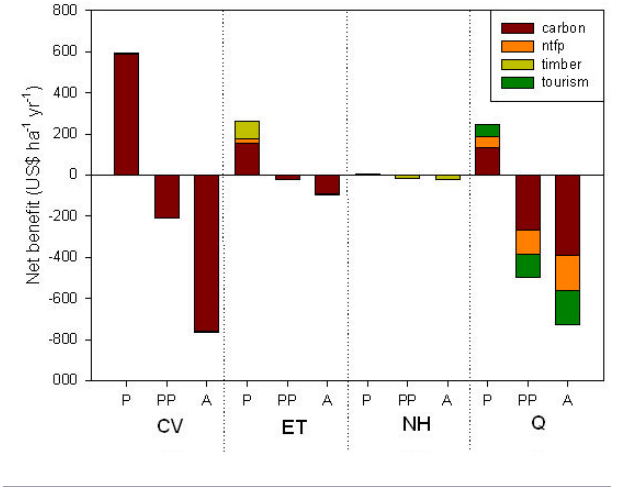
Fig. 4 . Net benefit of forest landscape restoration (FLR), based on assessment of the values of four ecosystem services (carbon storage (“carbon”), non-timber forest products (“ntfp”), timber production (“timber”) and nature- related tourism activities (“tourism”)). The net benefits were estimated through estimation of the combined net value of these ecosystem services across the study landscapes resulting from FLR, taking the costs of restoration activities into account. Restoration scenarios were: P, passive (no restoration costs); PP, passive with protection (costs of fencing and fire suppression); and A, active (costs of tree planting, fencing, and fire suppression). The four study areas are: CV, Central Veracruz, Mexico; ET, El Tablon, Mexico; NH, Nahuel Huapi, Argentina; Q, Quilpue, Chile. Figure redrawn from the analyses presented by Birch et al.